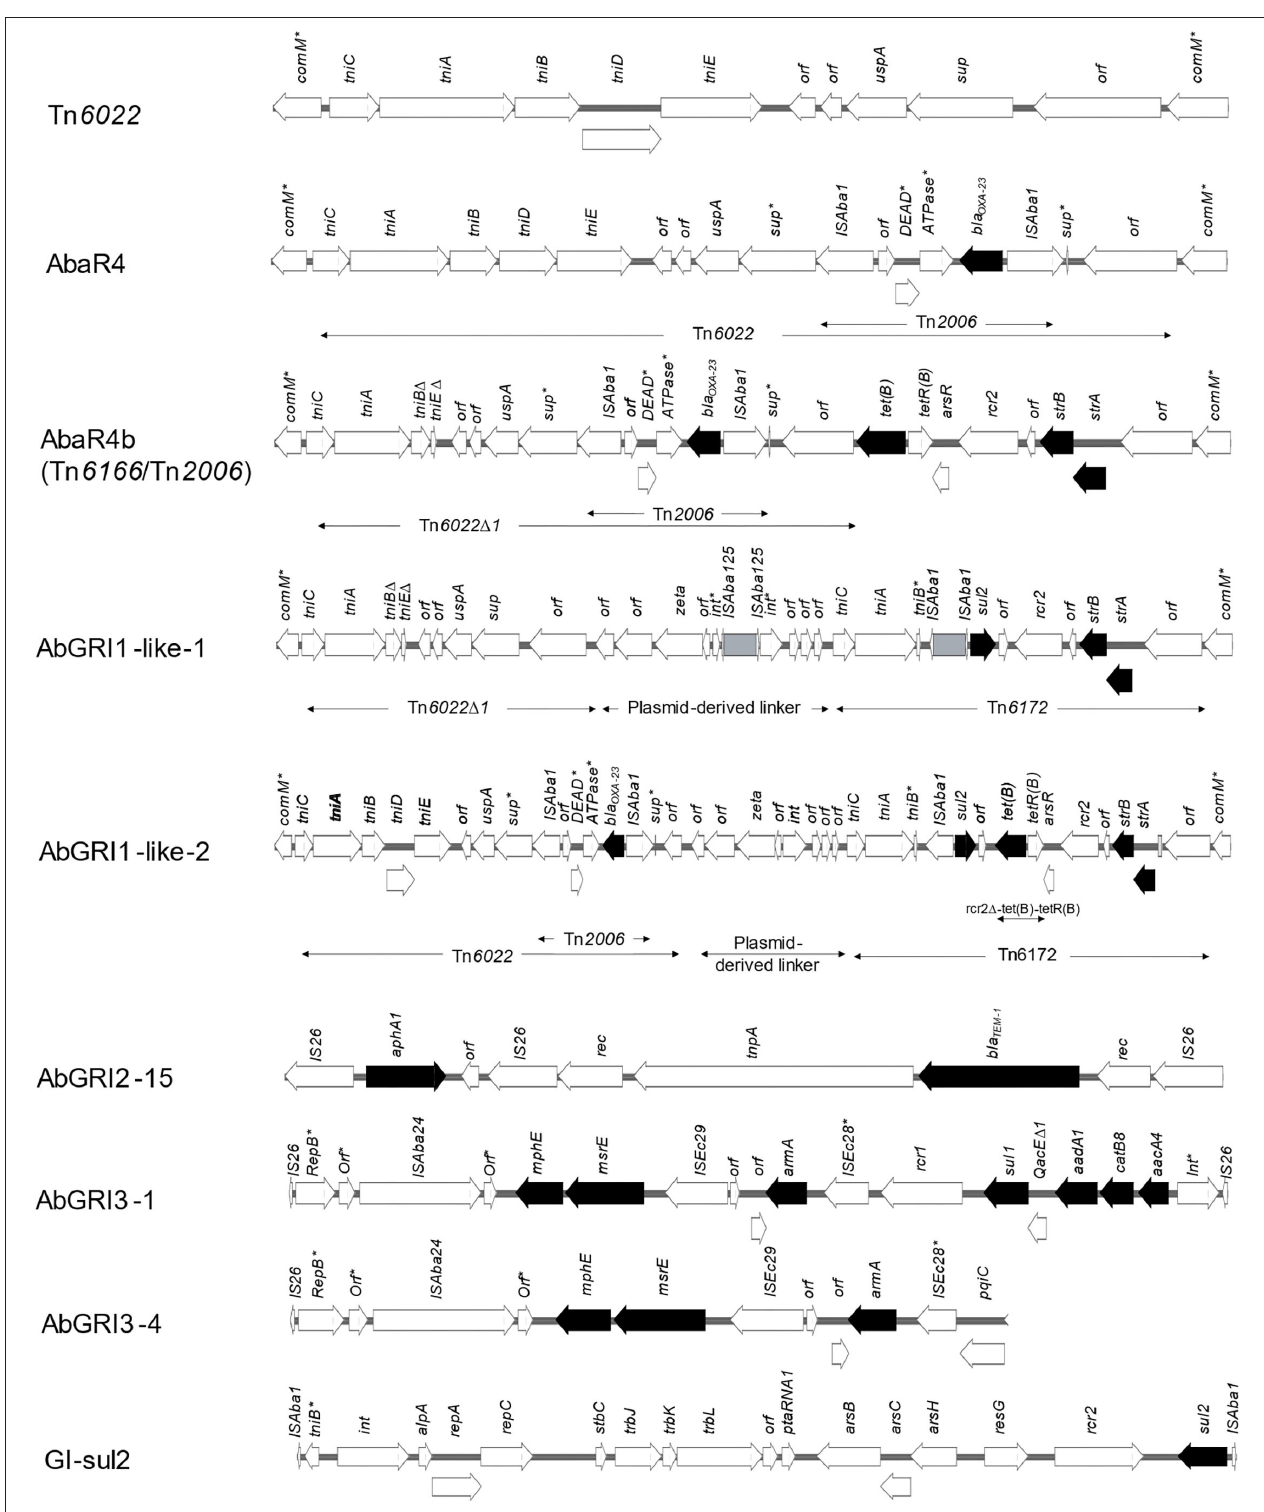
FIGURE 4 | Structures of resistance islands identified in the current study. Nine types of genomic RIs were identified in the isolates. These included Tn 6022 , AbaR4, three AbGRI1 variants, one AbGRI2, two variants of AbGRI3, and GIsul2. Arrows denote open reading frames. Antimicrobial resistance genes are represented by black arrows. Asterisks indicate interrupted